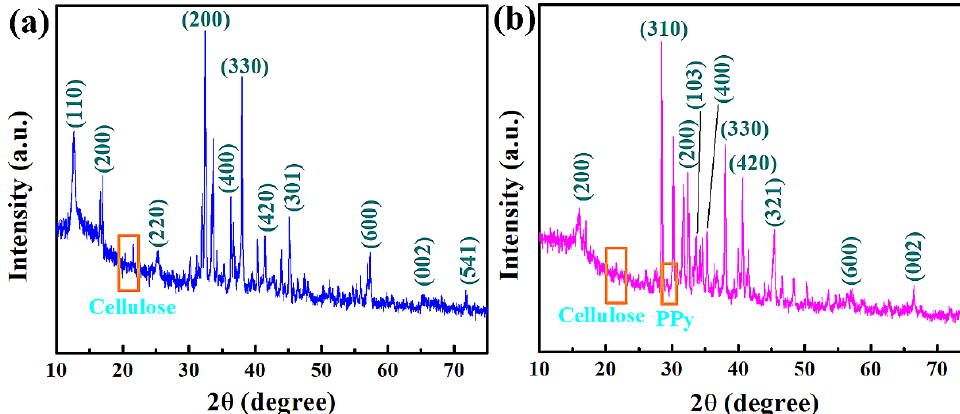
Figure 4. XRD analysis of ( a ) MnO 2 @CE and ( b ) MnO 2 @CE/PPy.